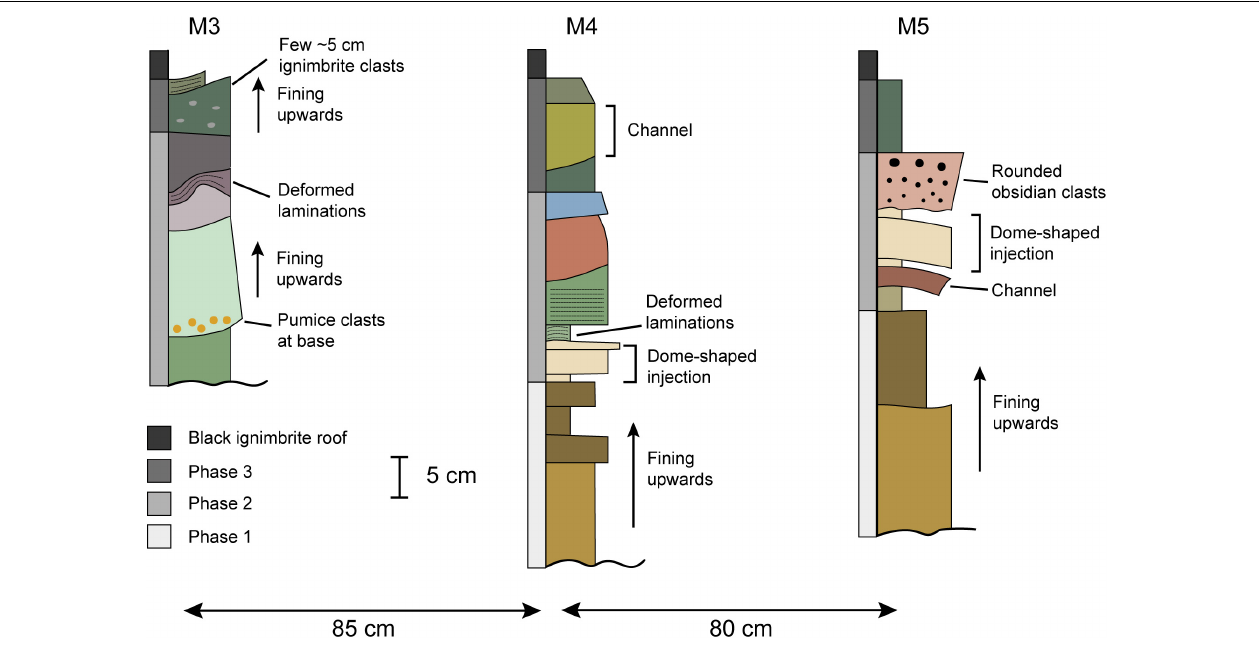
FIGURE 5 | Three graphic logs of the tuffisite each spaced about 80 cm apart. The locations of logs are labelled in Figure 4 , and beds are given corresponding colours. The tuffisite is composed of fining upwards sequences, interrupted by coarser laterally discontinuous units. The deposition of units can be separated into three different phases, allowing for an overall model of tuffisite emplacement to be